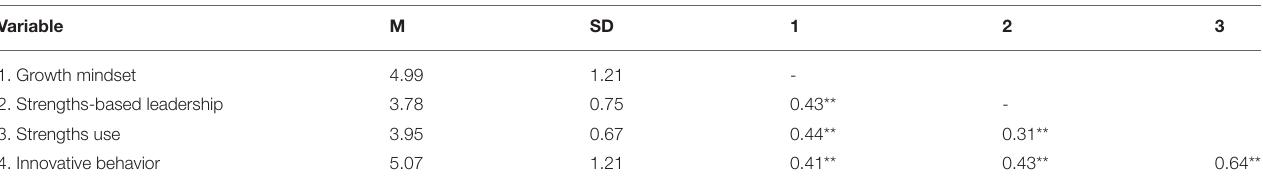
TABLE 3 | Means, standard deviations, and correlations.